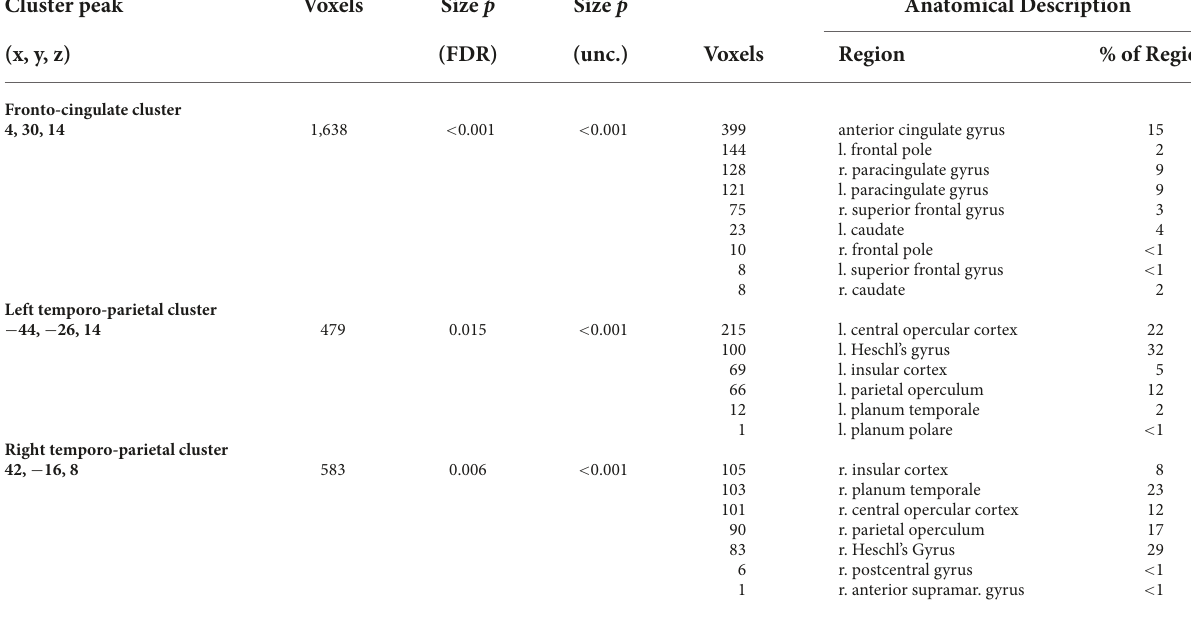
TABLE 2 ROI-to-voxel analysis: interaction-contrast results. Cluster peak Anatomical